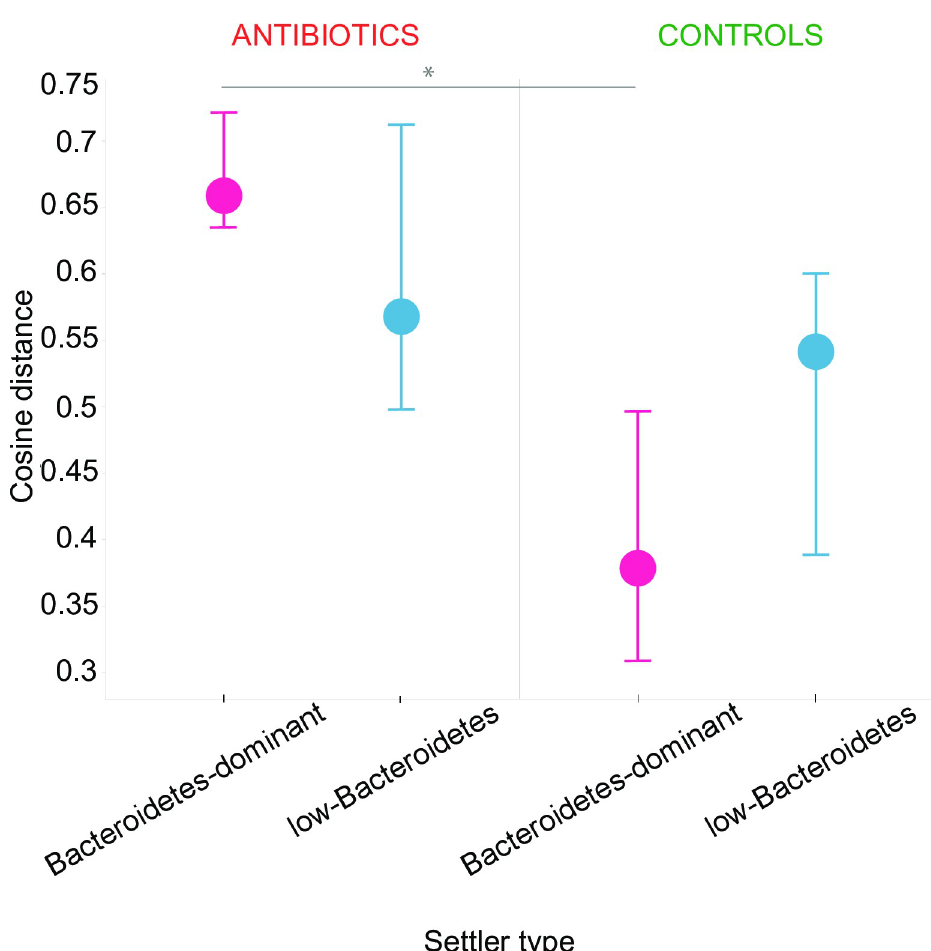
Fig 4. Cosine distances as a measure of community dissimilarity within individuals over time by settler type and treatment group. Cosine distances displayed by settler type in antibiotic treated infants (left) and controls (right). Distances shown are between one week of age (T = 1) and three months of age (T = 3) within each individual. Dots indicate median cosine distances (during the 3-month interval) of all individuals of each settler type; bars indicate IQR (inter quartile